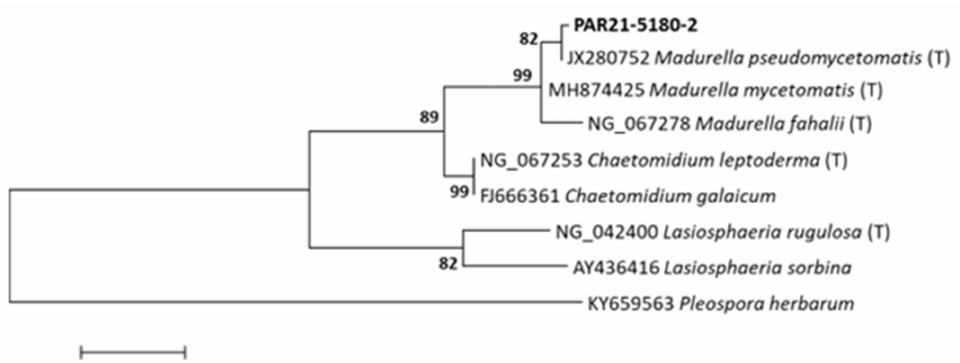
Figure 3. Phylogenetic tree based on portions of the 28S LSU sequences of various members of the order Sordariales. In boldface, PAR21-5180-2 was the sequence produced in our study. The Pleospora herbarum sequence was used as an outgroup. The maximum likelihood method was used to construct the tree. Bootstrap values shown at the main nodes represent the probabilities based on 1000 replicates. (T) = type